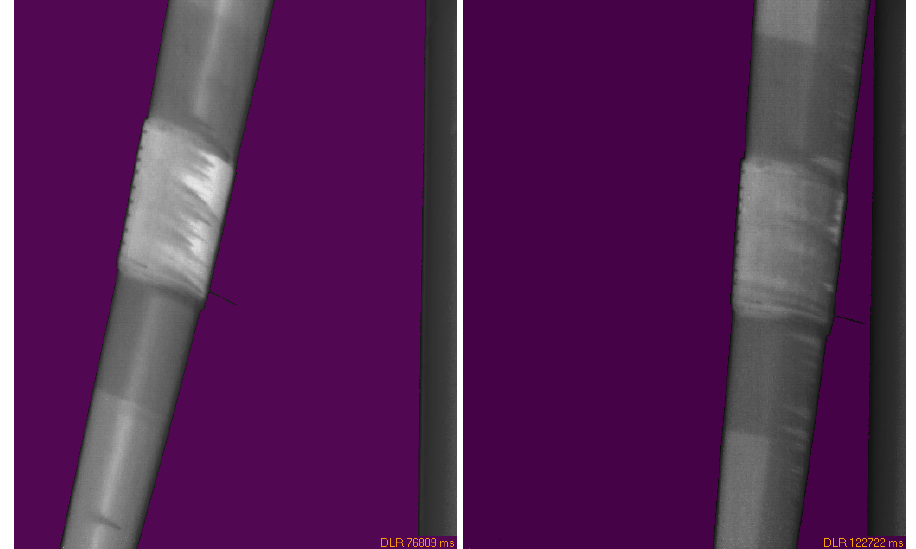
Figure 17. Two typical thermal images obtained by DLR setup after image processing including bad-pixel elimination, sky–background replacement, and contrast enhancement. Images are from 11:22:27 ( Left ) and 11:23:13 ( Right ), both SCADA time). Left shows more laminar parts during startup, and right only very small extended regions during constant rpm (approximately 9) operation mode.